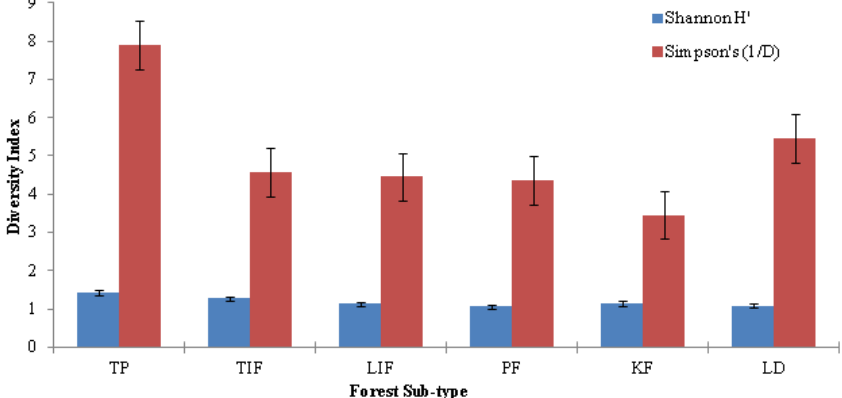
Figure 6. Diversity indices for all of the plant communities studied in the Caimpugan peat swamp forest. The plant communities are: tall pole forest (TP), tall intermediate forest (TIF), low intermediate forest (LIF), pygmy forest (PF), Kasawangan forest (KF) and Lycopodium-Dicranopteris community (LD). The error bars indicate ±